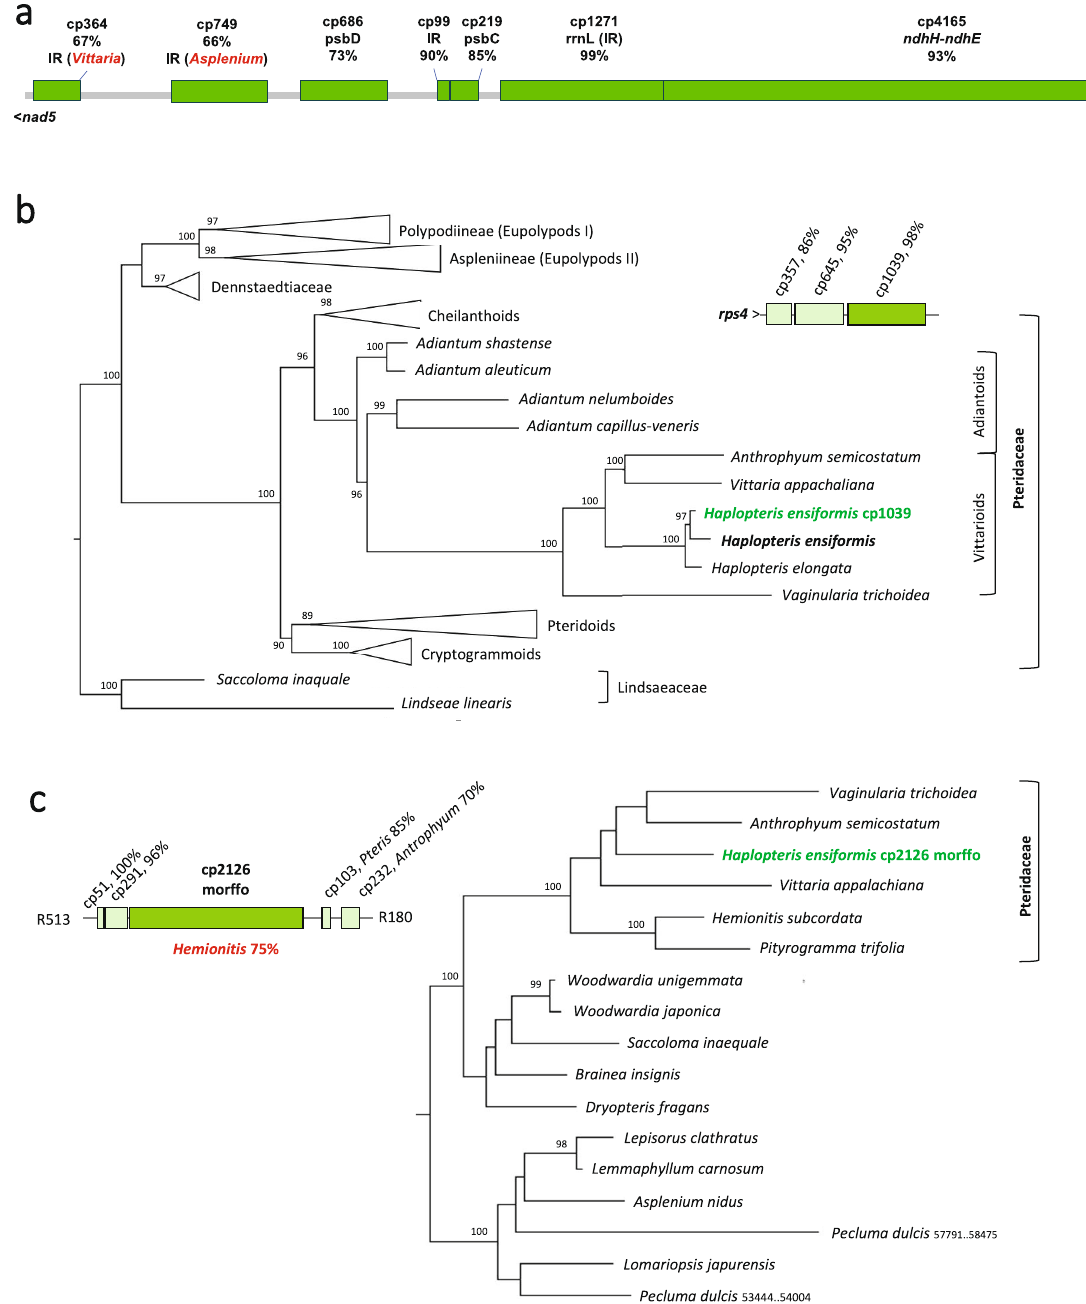
Fig. 6 A multitude of chloroplast DNA inserts in the Haplopteris ensiformis mitogenome. Selected examples for altogether approximately 80 inserts of chloroplast DNA populating the Haplomitrium ensiformis mitogenome (see Supplementary Data 3). Maximum likelihood trees were constructed with IQ-TREE 92 after automatic model selection of TIM + F + I + G4 or GTR + F + I + G4 and trees were rooted with the Lindsaeaceae family or the Eupolypod II clade, respectively, for cp1039 and cp2126. Bootstrap support is derived from 500 replicates. a The intergenic region between nad5 and sdh4 contains the largest collection of likely independently acquired cpDNA inserts including the largest individual insert cp4165 with 93% similarity to the native chloroplast ndhH-ndhE region. The other inserts share variable sequence identities with the native H. ensiformis cpDNA ranging from 73% for cp686 to 99% for cp1271. Inserts cp364 and cp749 lack evident homologies in the H. ensiformis plastome, but are identi fi ed by sequence similarities to cpDNAs in other fern genera like Asplenium or Vittaria , highlighted in red. b Chloroplast DNA insert cp1039 derived from the chloroplast atpA-atpF region is an example for a likely very recently acquired insert as evident from its well-supported sister placement to the newly assembled H. ensiformis cpDNA (Fig. 1) in a phylogeny including the homologous plastome regions from diverse polypod ferns. c Chloroplast insert cp2128 embedded in other cp inserts of variable sequence conservation carries a unique morffo element, identi fi ed by sequence similarity only in the cpDNA of Hemionitis subcordata